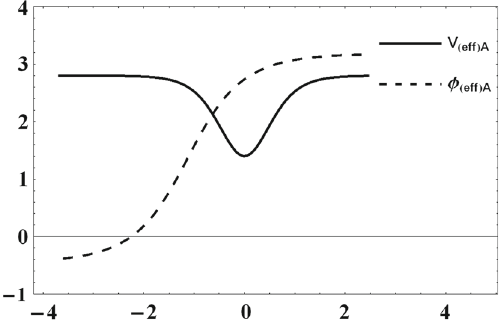
Fig. 2 Thephantomscalarfieldrepresentationofmodel A .Solidcurve shows the effective potential and the dashed one indicates the phantom scalar field where β = ( 1 − w 2 )/ 2 ( 3 w − 1 ) and we have dropped sub- scripted A . Note that the validity of solution (28) requires that β > 0. The system (46)–(48) has two critical points far √ − P / 3 , 0 ) which corresponds from the bounce; P ( ± ) = ( ± ∓√ − P / 3 , 0 ) . We see that the to the eigenvalues λ ( ± ) = ( stability properties of solutions are independent of w . Due to the appearance of the zero eigenvalues, one may not decide about the stability properties of these fixed points, however, by inspecting Eqs. (46) and (47) it is possible to figure out the nature of the fixed points. For fixed point P ( − ) Eq. (47)